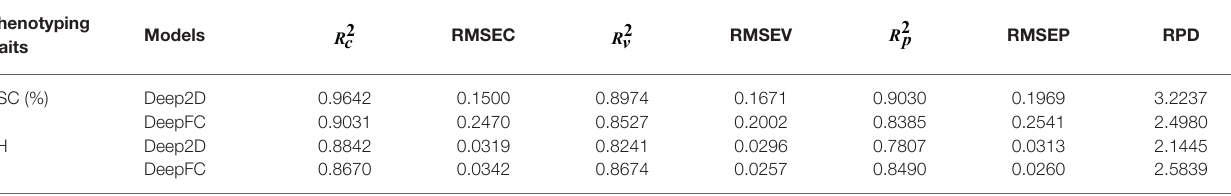
TABLE 2 | Prediction of SSC and pH using Deep2D and